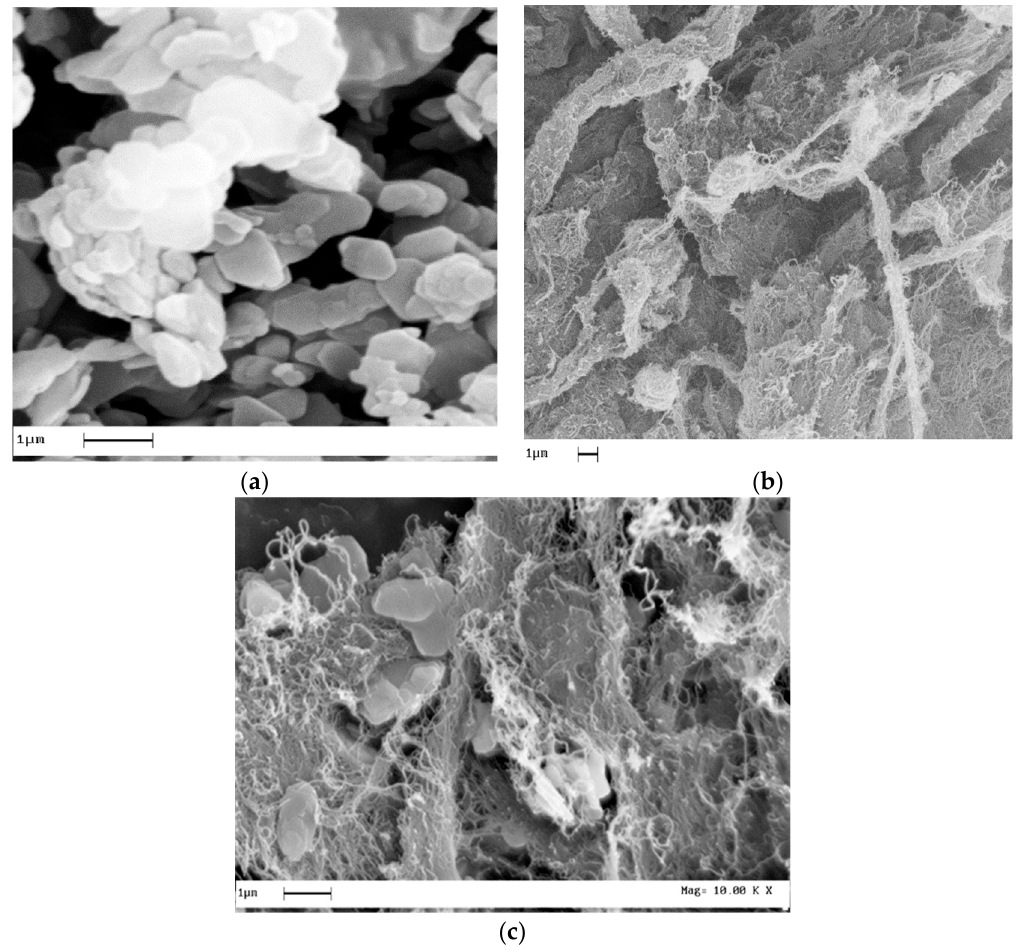
Figure 1. SEM analysis of ( a ) pristine layered double hydroxides (LDH), ( b ) pristine CNT and ( c ) LDH-CNT. ( c )